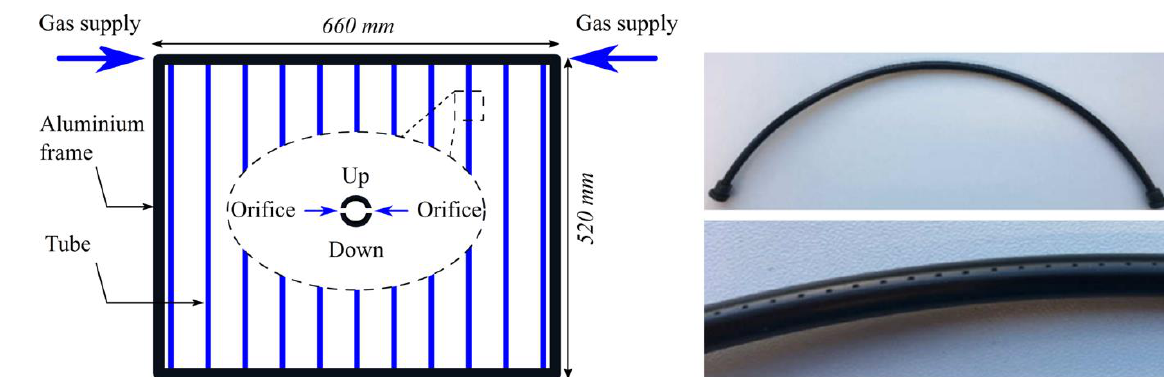
Figure 3. Illustration scheme of aluminum frame with micro-perforated tubes ( left ); micro-perforated tube with length of 500 mm and an outer diameter of 6 mm ( top right ); close-up view of tube with orifices of 50 µm in diameter ( bottom right ).